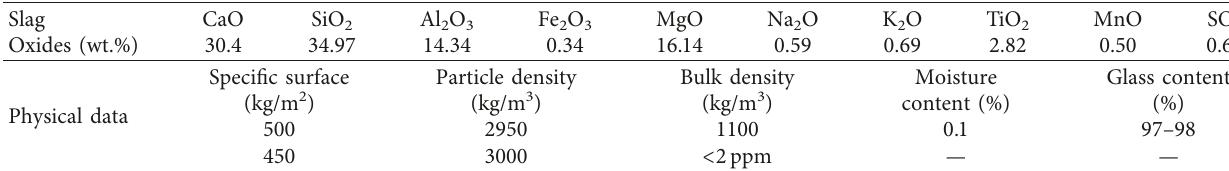
Table 1: Physical and chemical properties of binders.